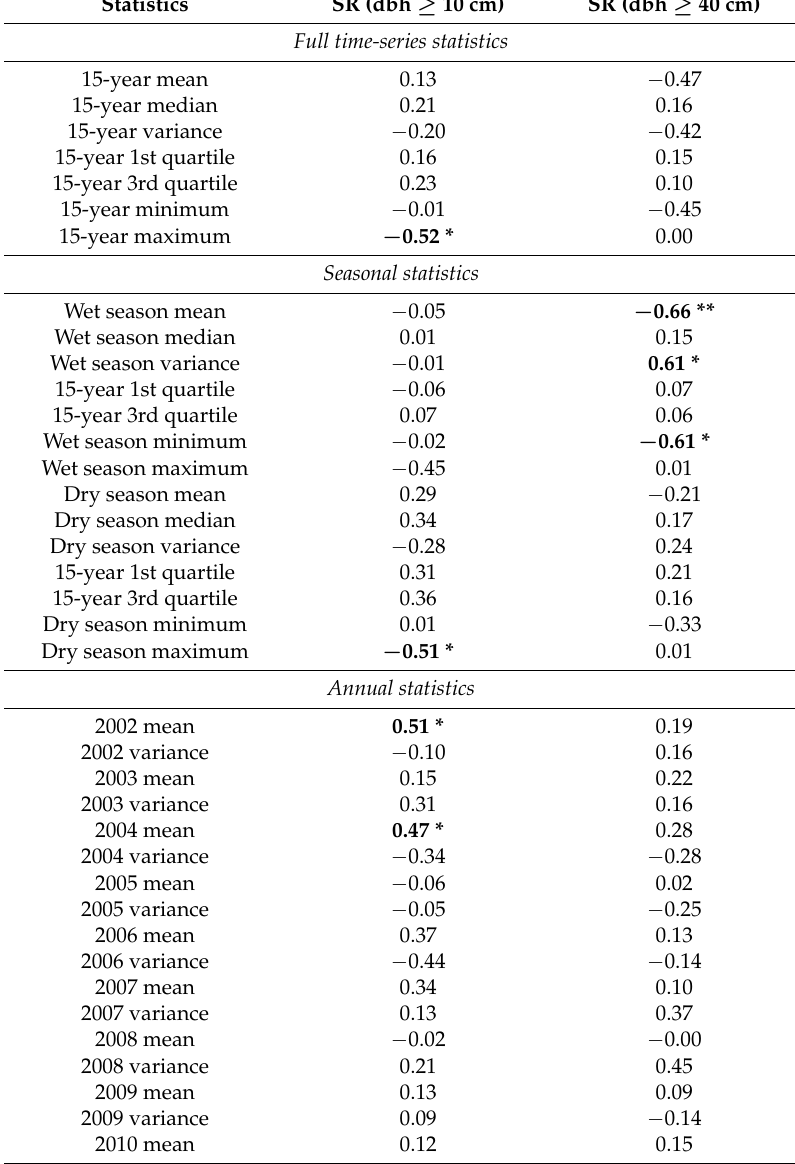
Table 2. Correlation between basic descriptive statistics extracted from a 15-year time series of MODIS NDVI images produced on six-day intervals and species richness (SR) measured in 19 one hectare plots in New Caledonia. Asterisks refer to the level of significance: 0.05 < p < 0.01 (*); 0.01 < p < 0.001 (**); p < 0.001